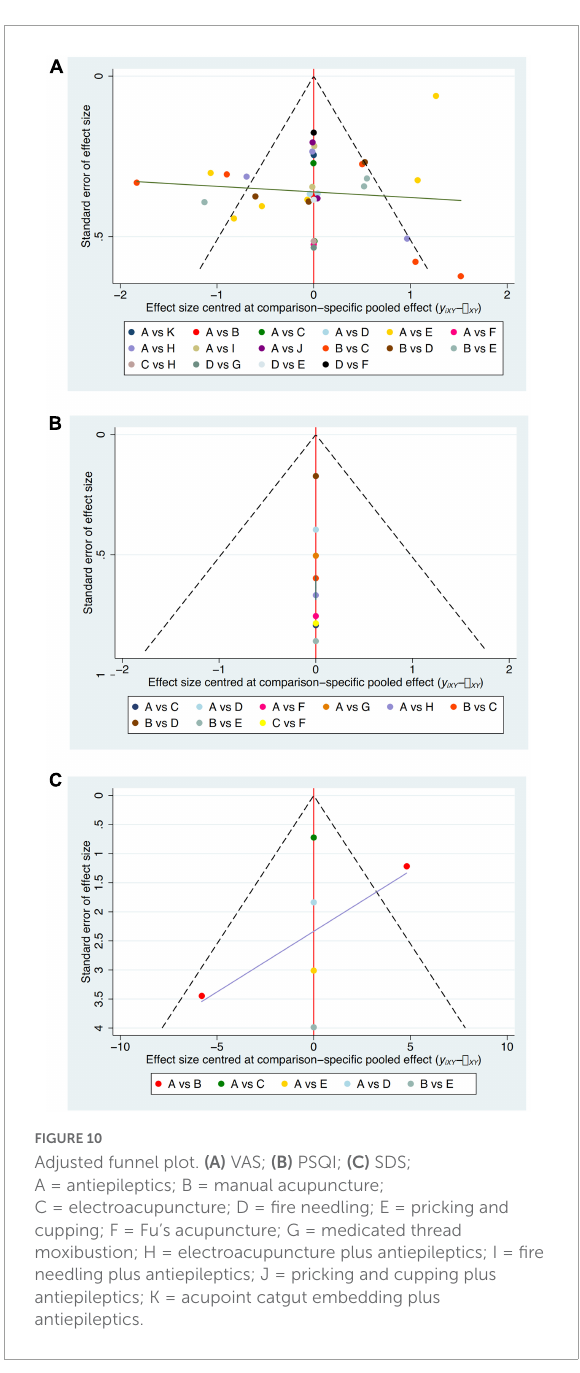
FIGURE10 Adjusted funnel plot. (A) VAS; (B) PSQI; (C) SDS; A = antiepileptics; B = manual acupuncture; C = electroacupuncture; D = fire needling; E = pricking and cupping; F = Fu’s acupuncture; G = medicated thread moxibustion; H = electroacupuncture plus antiepileptics; I = fire needling plus antiepileptics; J = pricking and cupping plus antiepileptics; K = acupoint catgut embedding plus